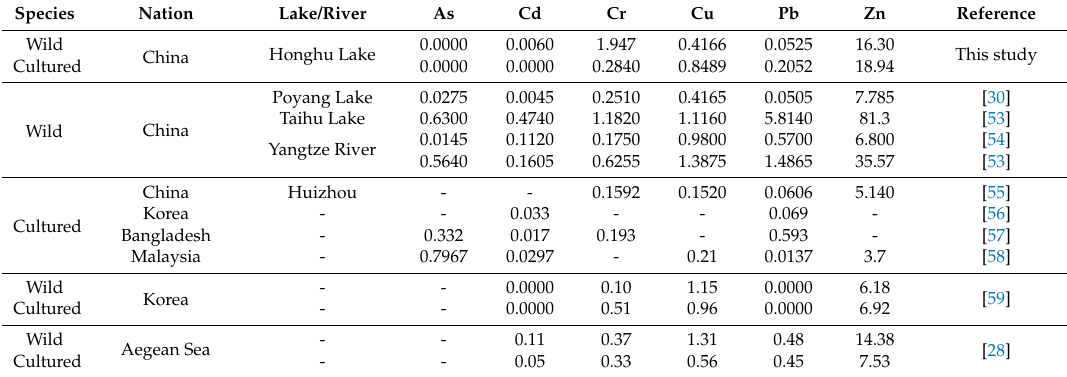
Table 3. Trace element concentrations in fish muscles of typical areas (mg/kg; wet wt). Species Nation